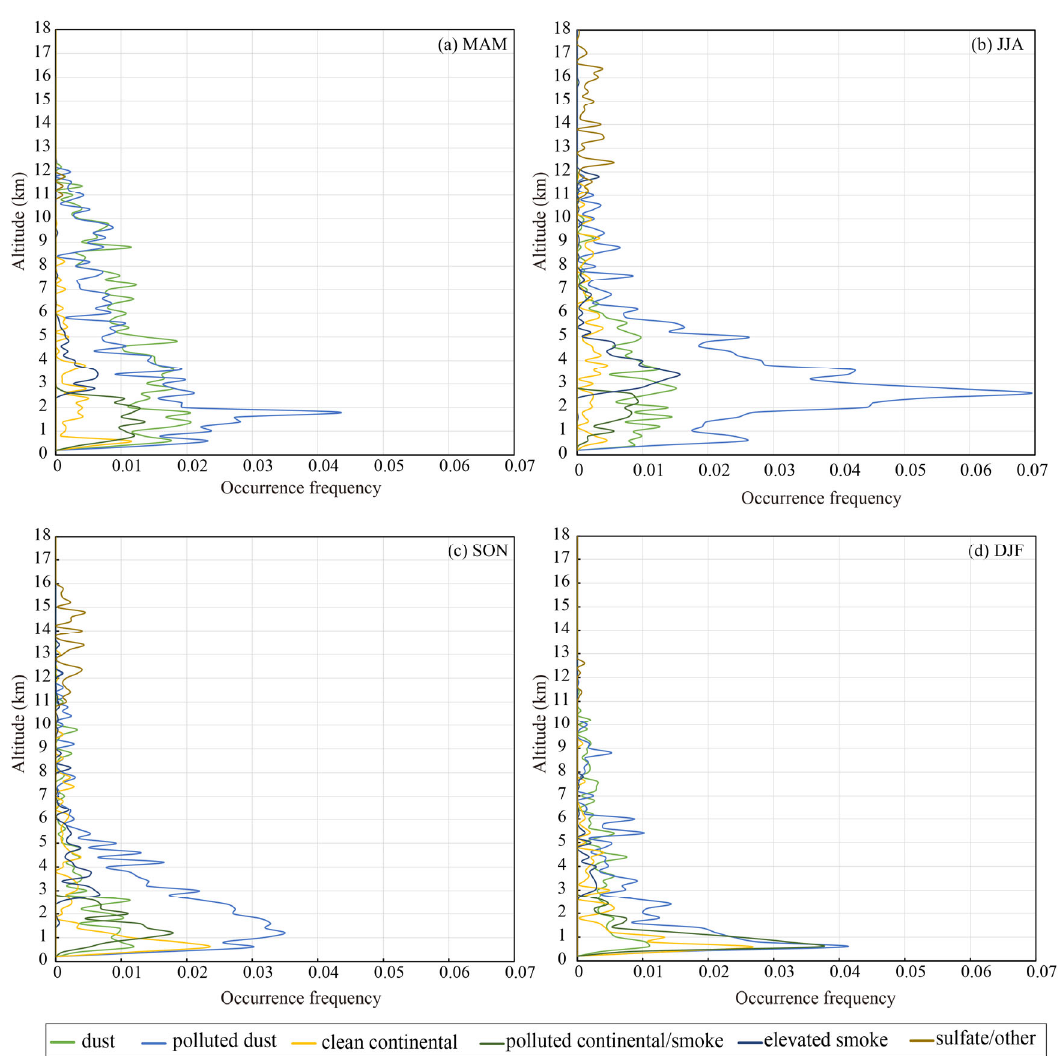
Figure 6. Vertical distributions of the occurrence frequency of aerosol layer over the Aral Sea Basin in different seasons (MAM, JJA, SON, and DJF) from 2007 to 2021.